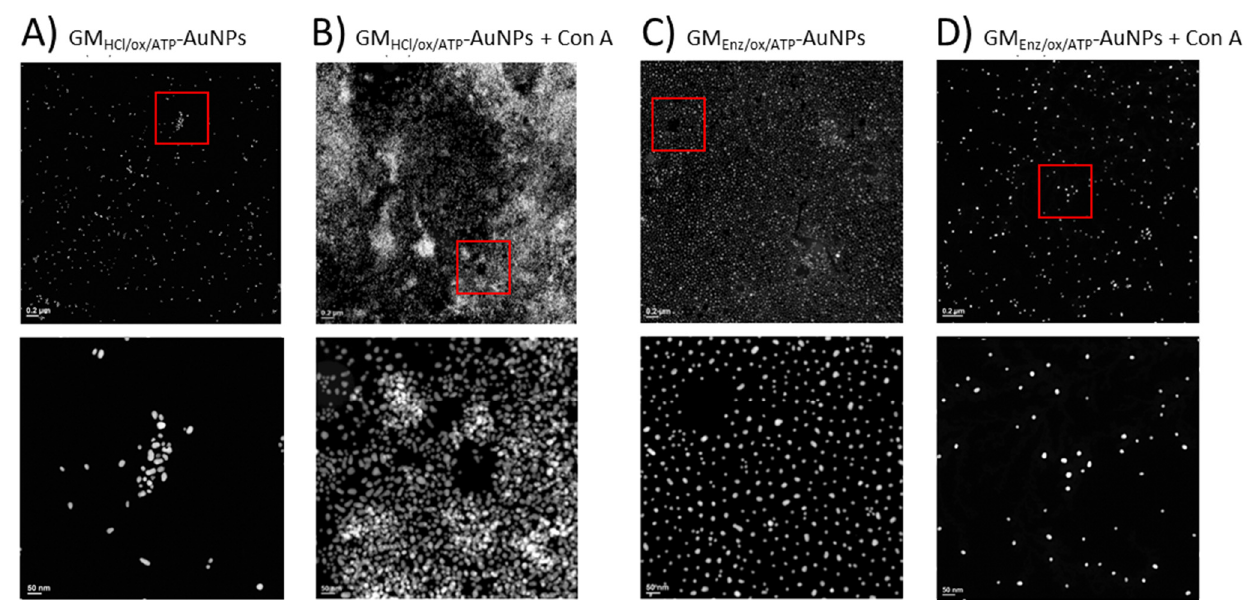
Figure 9. TEM images of GM HCl/ox/ATP glyconanoparticles (6.0 nM) ( A ) before and ( B ) after the addition of 0.352 µM Con A. TEM images of GM Enz/ox/ATP glyconanoparticles (5.5 nM) ( C ) before and ( D ) after the addition of 0.352 µM Con A. The overall concentration of nanoparticles in the samples remained constant ( ≈ 4.7–4.8 nM). Scale bars are 0.2 µm (top row) and 50 nm (bottom row).